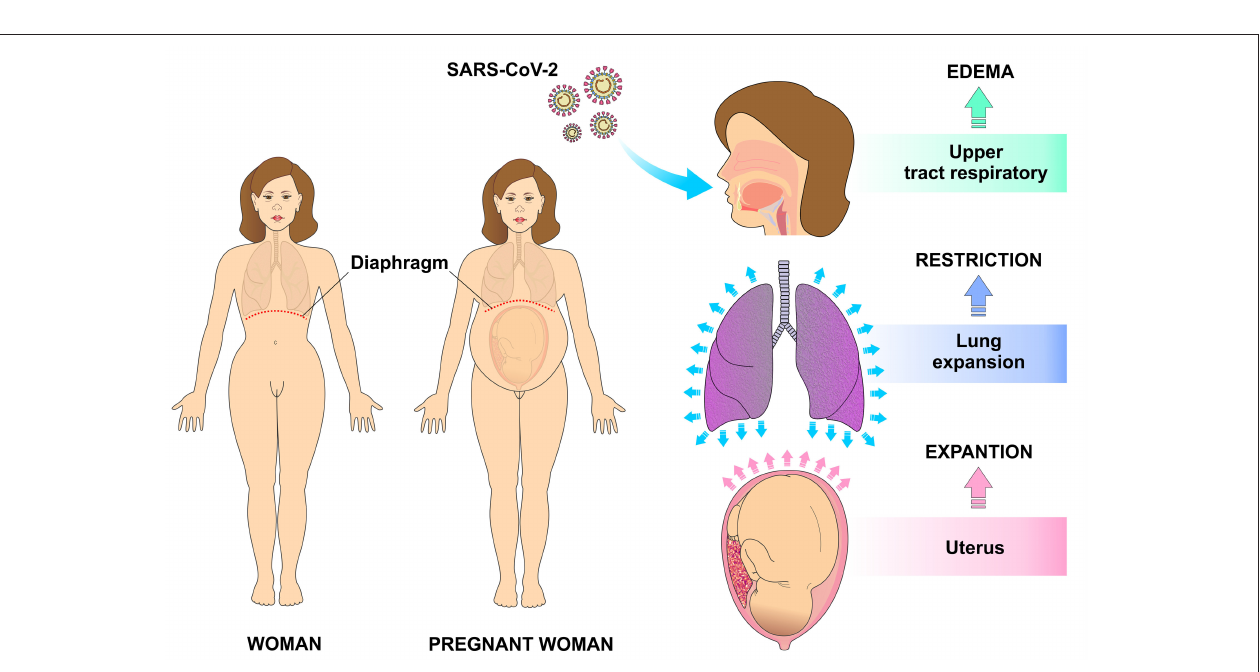
FIGURE 2 | Physiological changes in the respiratory system during pregnancy that make it more vulnerable for infection. The high levels of estrogen and progesterone result in edema of the upper respiratory tract also contribute to higher risk of infections. With uterine expansion, the diaphragm is displaced superiorly, making pulmonary expansion difficult and therefore decreasing the respiratory reserve